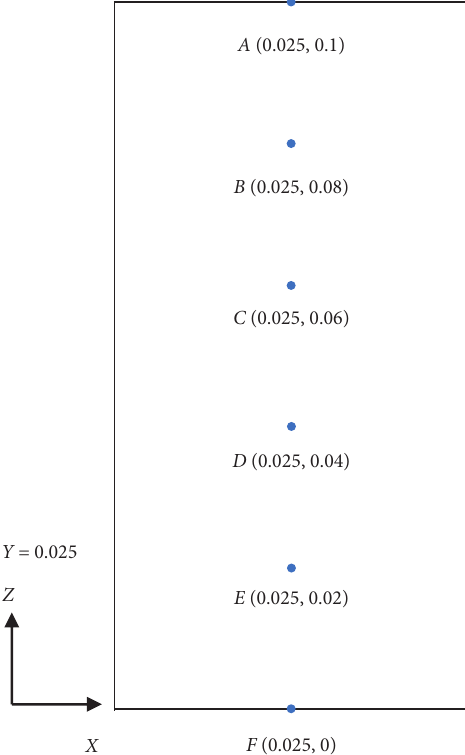
Figure 10: Cross-section of the model, in which 6 typical points where the stresses will be retrieved.